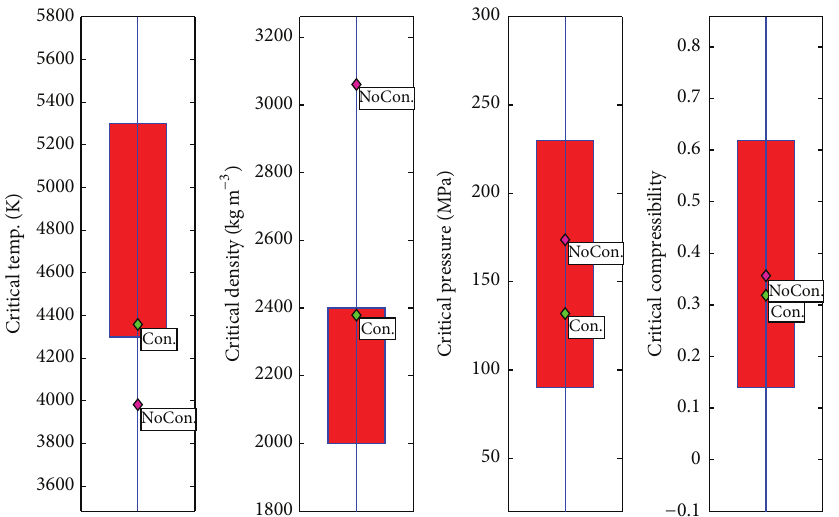
Figure 16: LBE critical parameters validity range and calculated values.